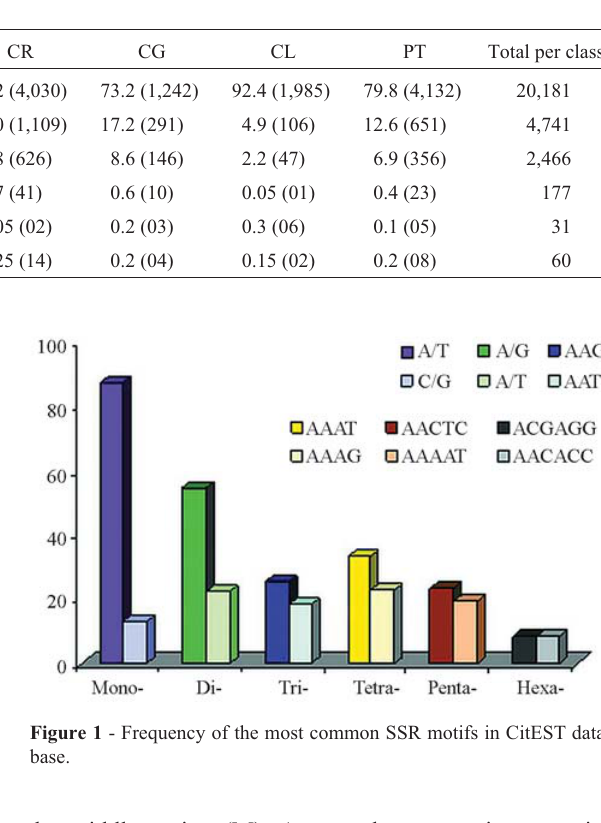
Table 2 - Frequency distribution (%) of EST-SSRs based on motif size for each species. Numbers within parentheses represent absolute number of microsatellites.